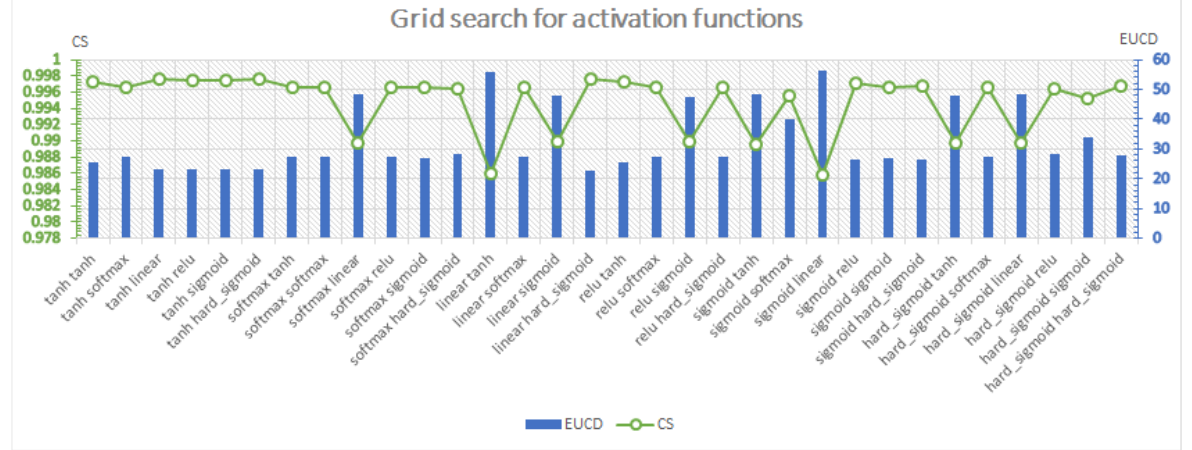
Figure 3. Grid search for activation functions through both ConvLSTM2D layers.